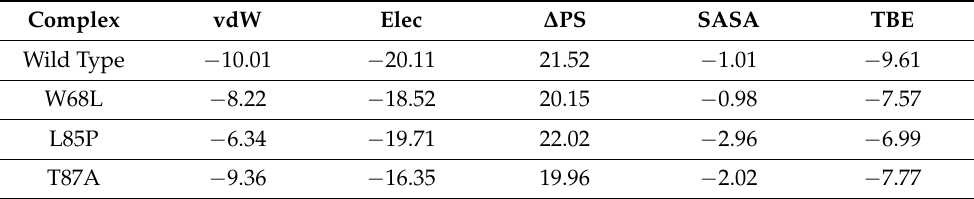
T87A systems represented in